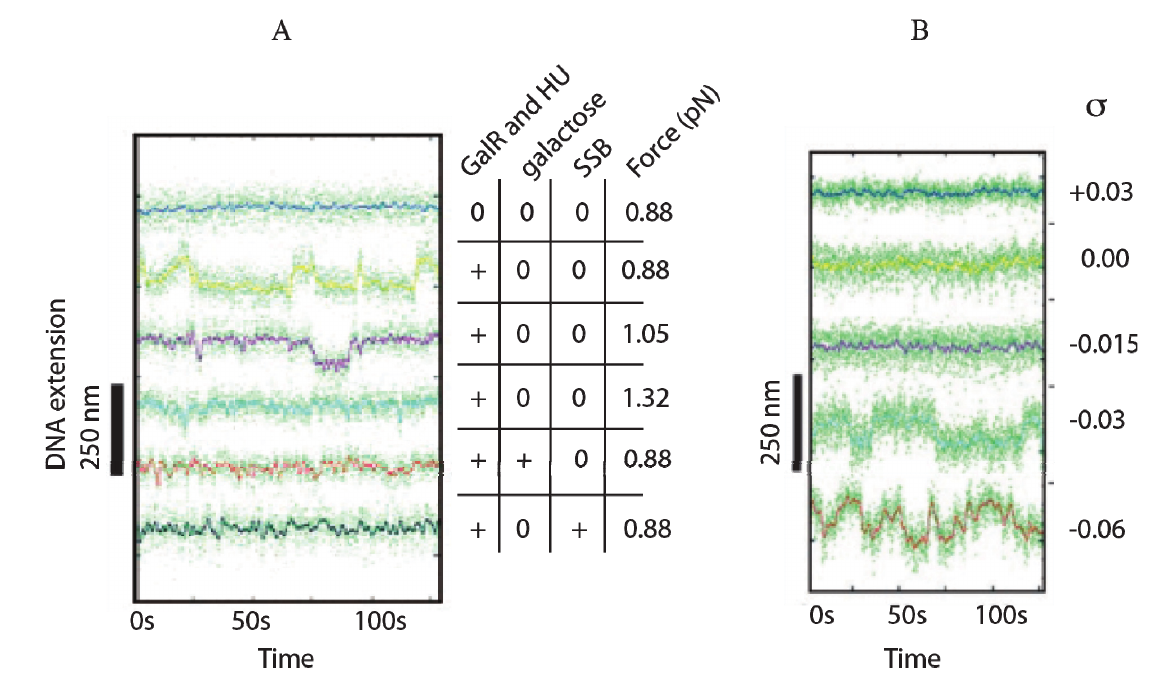
Figure 16. Single molecules of DNA looping. ( A ) Traces of DNA in the presence of GalR, HU, D -galactose or single-stranded DNA (SSB) with DNA supercoiling ((cid:5) = (cid:2)0.03) and magnetic forces of 0.88, 1.05 and 1.32 pN; ( B ) DNA looping vs. superhical density ((cid:5)) (reproduced with permission from the National Academy of Sciences, USA,